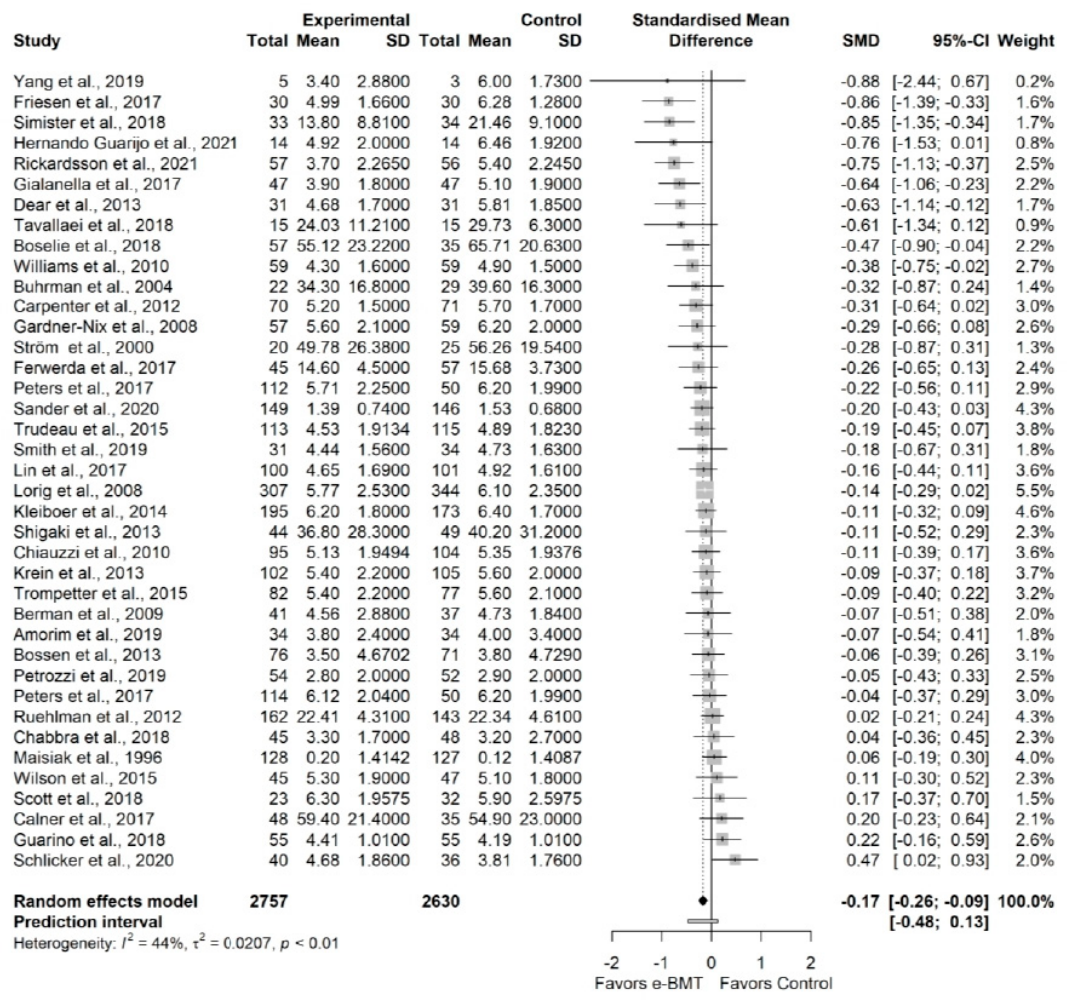
Figure 2. Synthesis forest plot of pain intensity variable of online behavioral techniques against in- person behavioral techniques. The forest plot summarizes the results of included studies (sample size, mean, standard deviation (SD), standardized mean differences (SMDs), and weight). The small boxes with the squares represent the point estimate of the effect size and sample size. The lines on either side of the box represent a 95% confidence interval (CI).